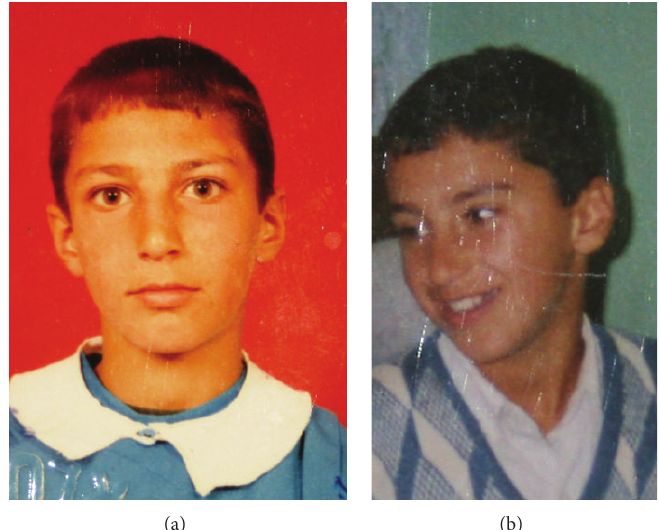
Figure 1: (a) At 8 years of age, very slight atrophy of the left side of the patient’s face was apparent. (b) The patient at 10 years of age.